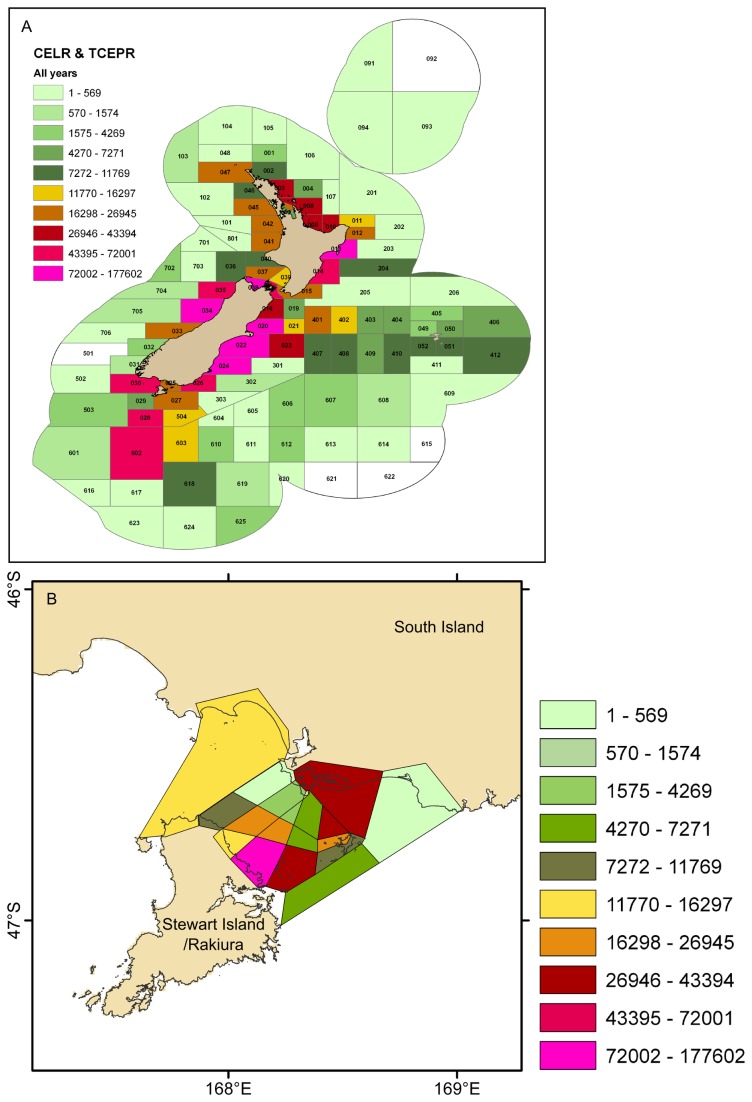
Bottom trawls and dredges for fishing years 1989–90 to 2004–05 inclusive.A) The distribution of bottom trawl effort in the New Zealand Exclusive Economic Zone, reproduced from Baird et al. [92] with permission from the Ministry for Primary Industries. B) The number of oyster dredge tows in Foveaux Strait (additional to trawls shown in A), by oyster statistical area, using data from Baird et al. [92]. An additional +2000 oyster dredge tows were reported from Foveaux Strait over the same period [92], but not by area, and are therefore not included here.